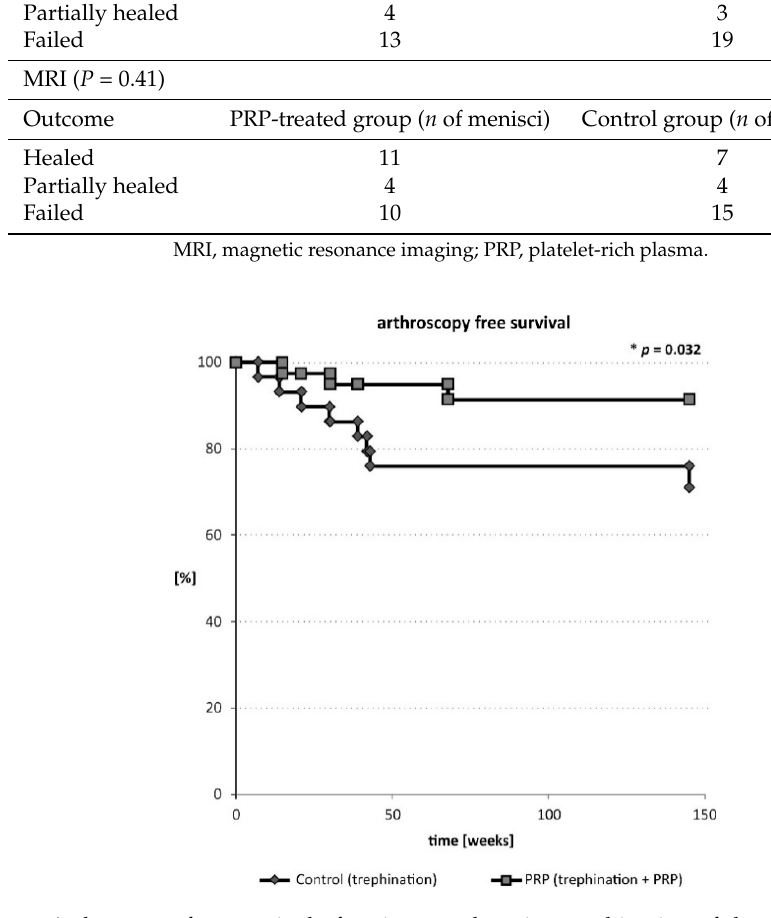
Figure 2. Arthroscopy free survival of patients undergoing trephination of the meniscus with or without PRP augmentation.